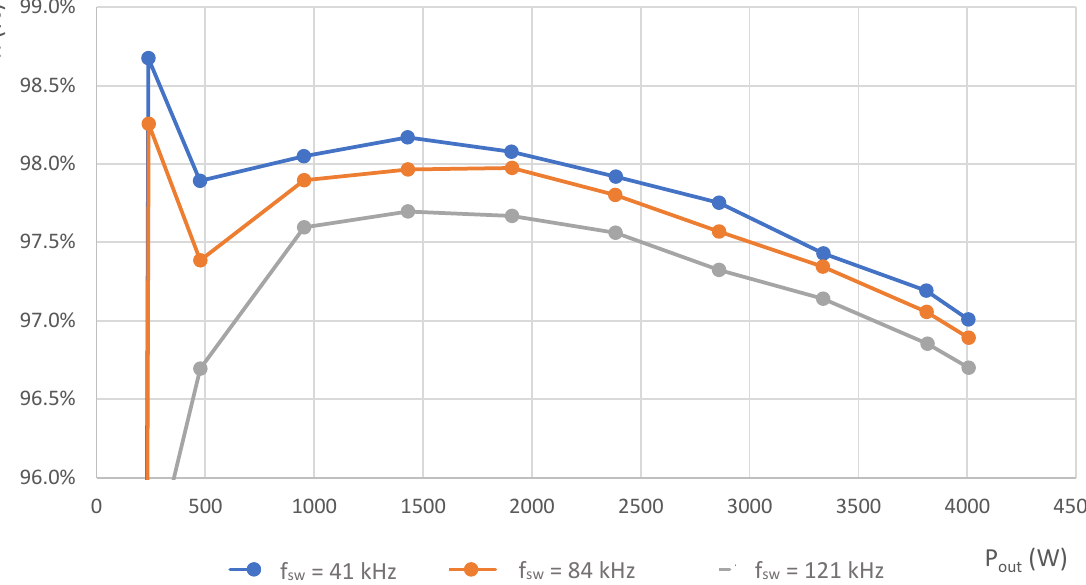
Figure 20. Efficiency waveform in dependency on the output power of converter (alloy core inductor). At 120 kHz switching frequency, a decrease in efficiency of 0.3% was recorded, which represents a difference of 13 W compared to 41 kHz